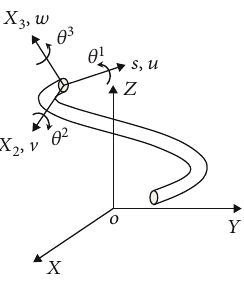
Figure 2: Displacements and rotations of the middle line in the Frenet coordinate